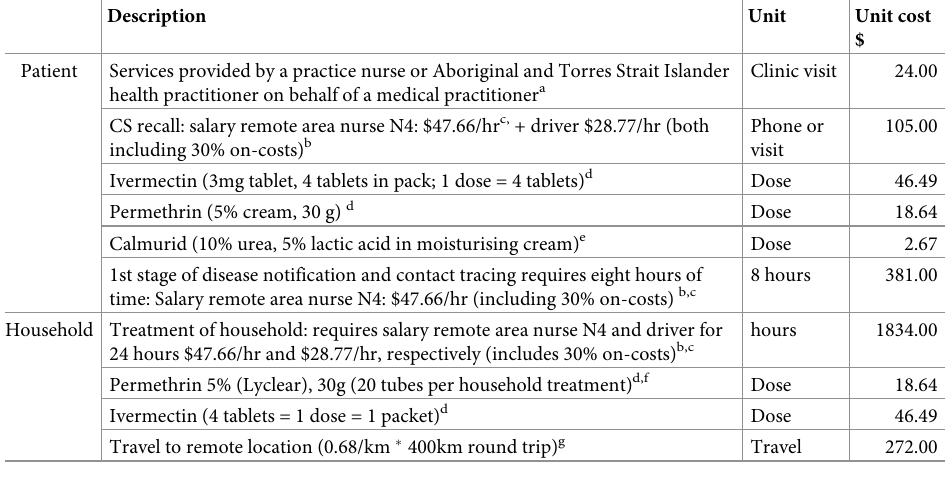
Table 2. Unit costs for resources used during the community follow-up phase of